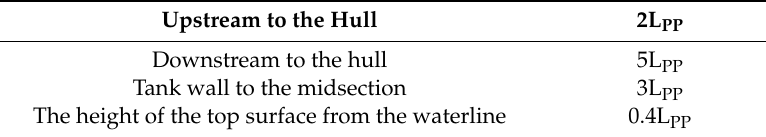
Table 4. The CFD computational domain size of the model-scale (full hull).